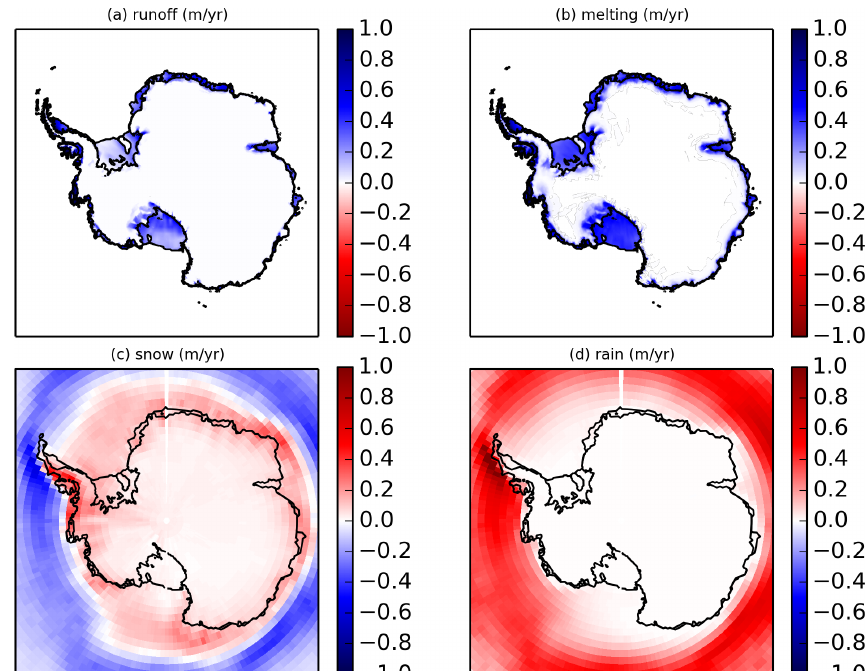
Figure 14. The difference between the average for 2090–2100 and average for 2020–2030 of SMB components in SSP5–8.5: (a) surface runoff, (b) surface melting (c) snowfall and (d) rainfall (all in myr − 1 ). Black lines indicate the grounding lines of the ice